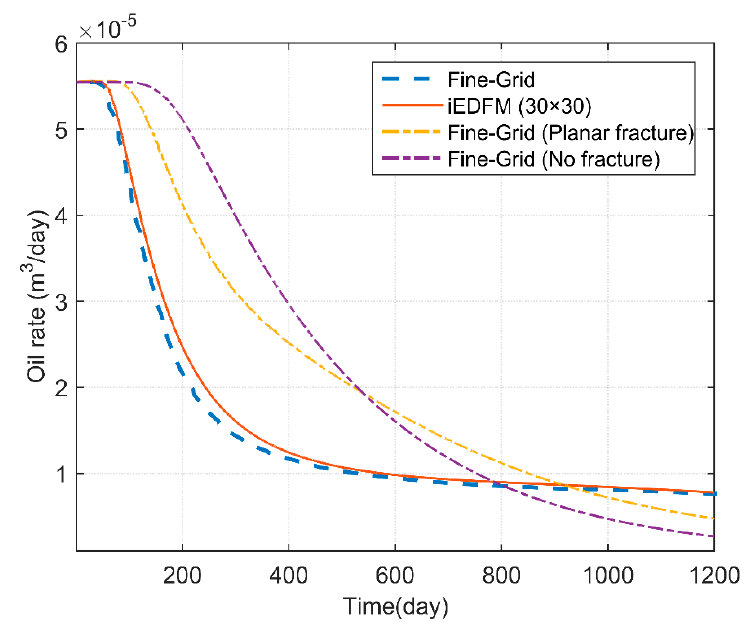
Figure 12. Comparison of oil production rate by the iEDFM/fine-grid model in Case 3.